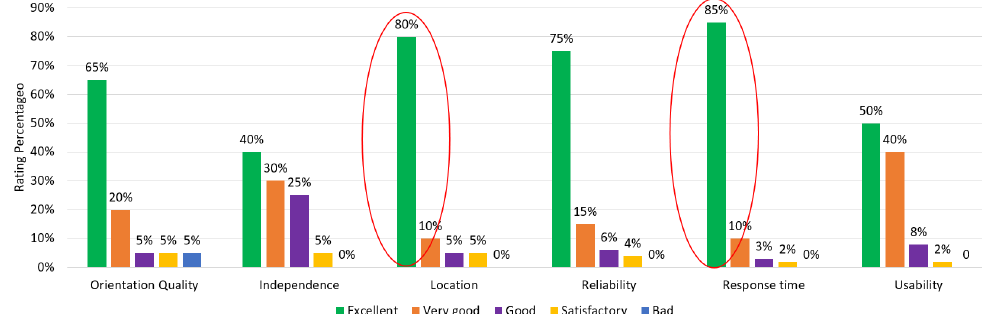
Figure 15. Detailed score of user-rated items.